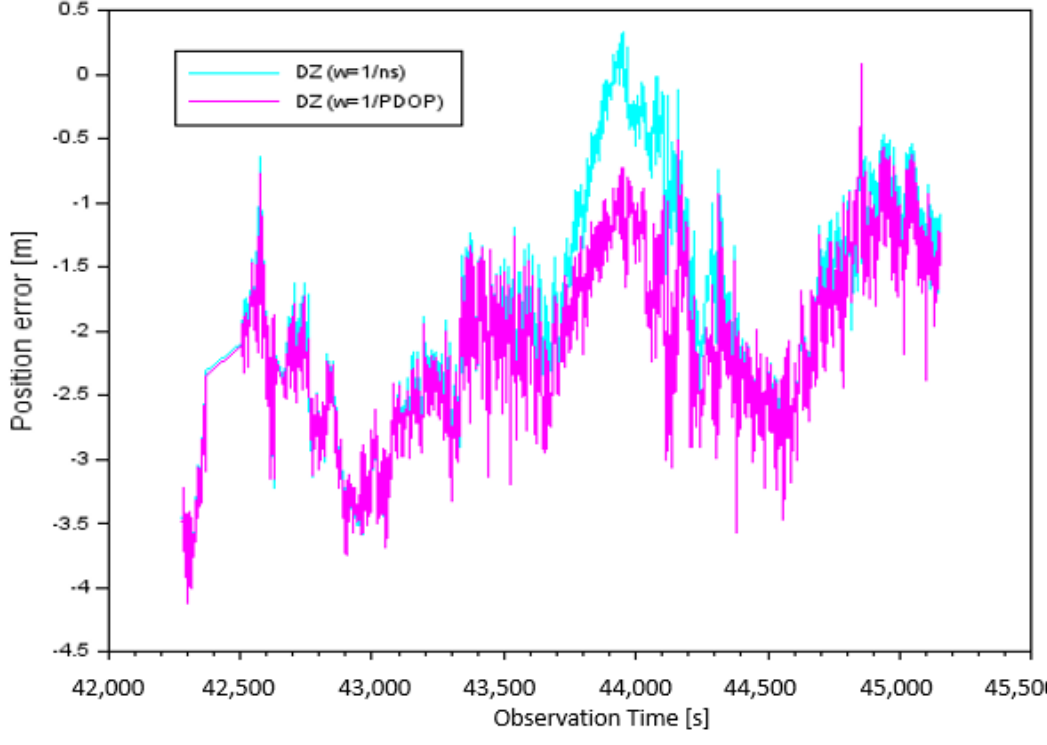
Figure 6. Position error along the Z-axis.